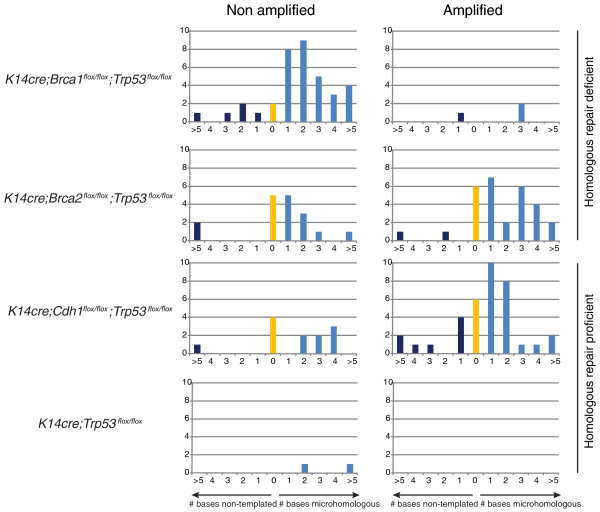
Overview of breakpoint sequence homology and non-templated DNA sequence per genotype. The bar plots show the amount of microhomology and non-templated DNA found binned by sequence length. The plots show aggregate values per genotype, separated into amplification-associated and non-amplification associated rearrangements.